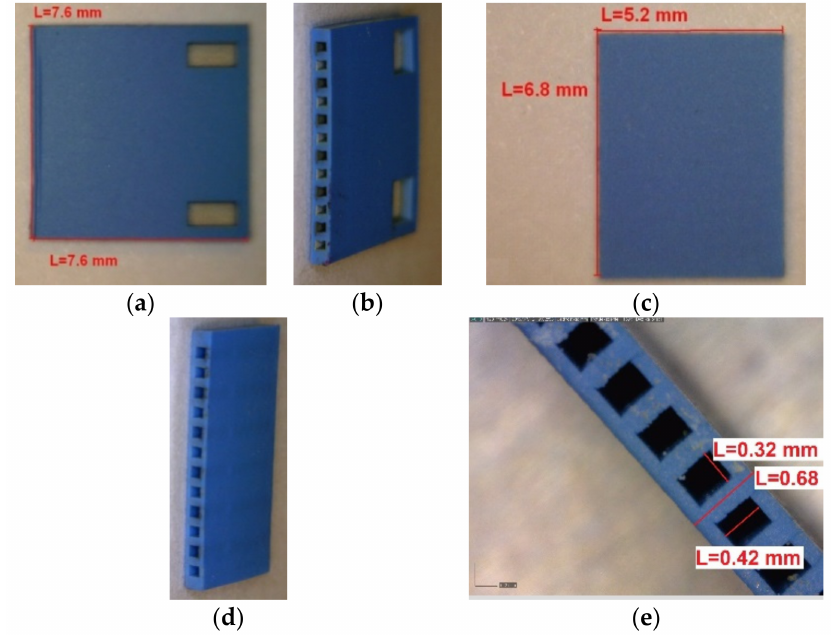
Figure 12. LTCC based structures with buried thermoelectric paths: ( a , b ) the structure for FAN_heat_sink; ( c , d ) the structure for CPU_heat_sink; ( e ) holes for thermoelectric wires